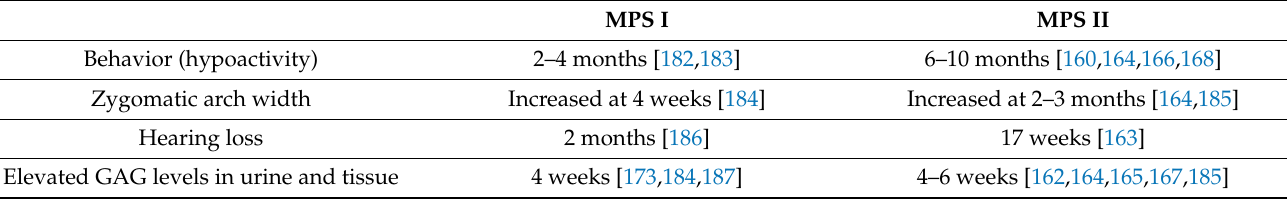
Table 3. Earliest time for manifestations in MPS I and MPS II mice.